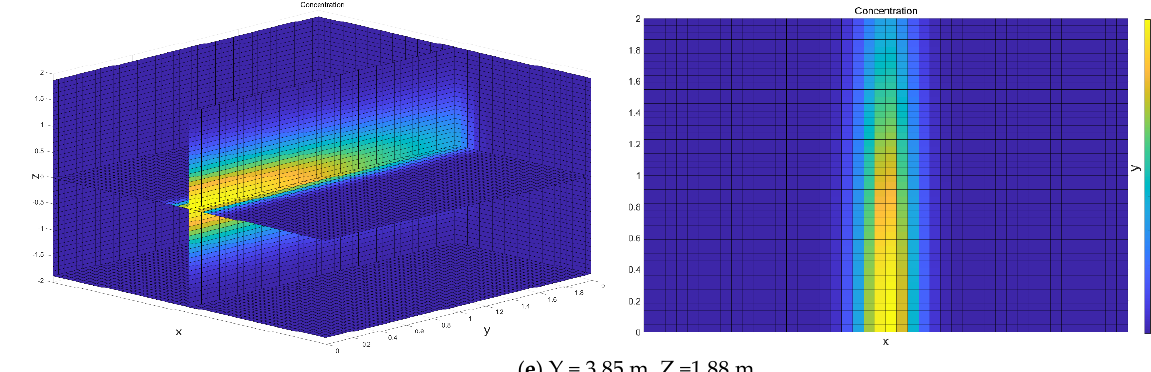
Figure 7. Concentration of transmission at different positions.